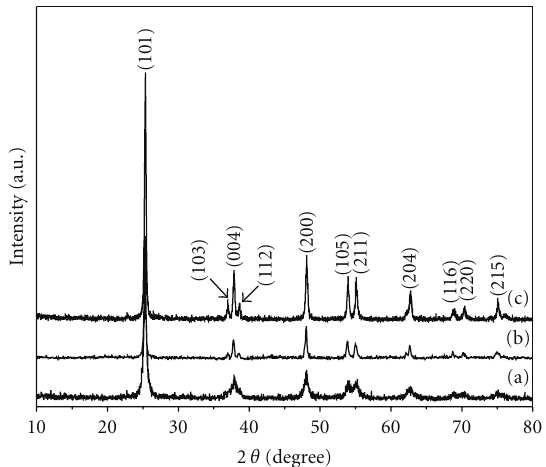
Figure 1: XRD patterns of the as-prepared samples calcined at (a) 500 ◦ C, (b) 600 ◦ C, and (c) 700 ◦